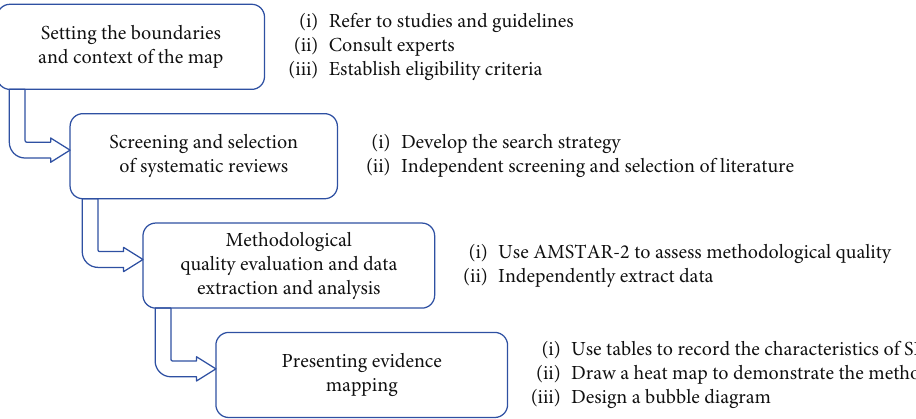
Figure 1: Tasks for performing evidence